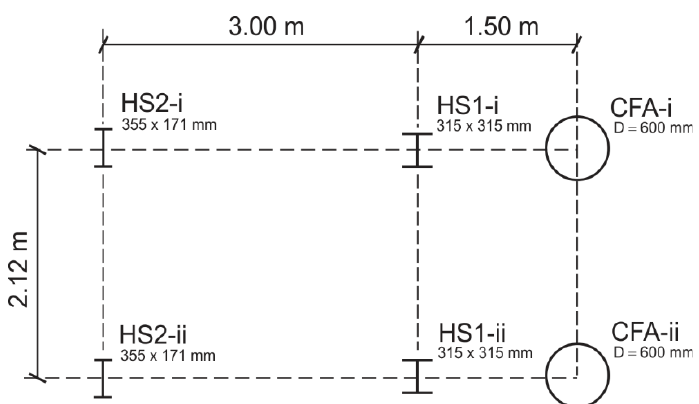
Figure 3. Elevation view showing the position of model